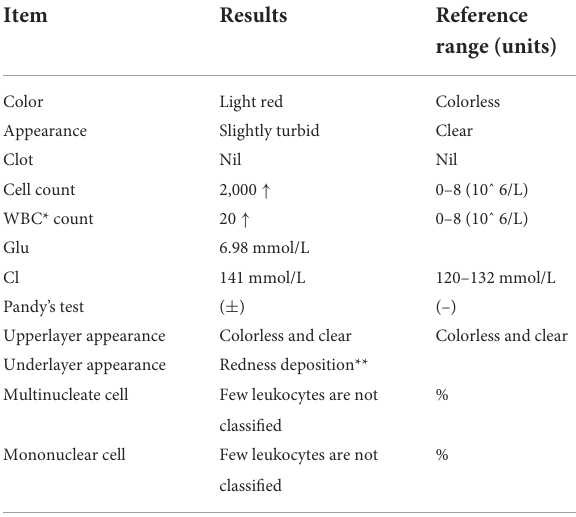
TABLE 1 Analysis of the cerebrospinal fluid